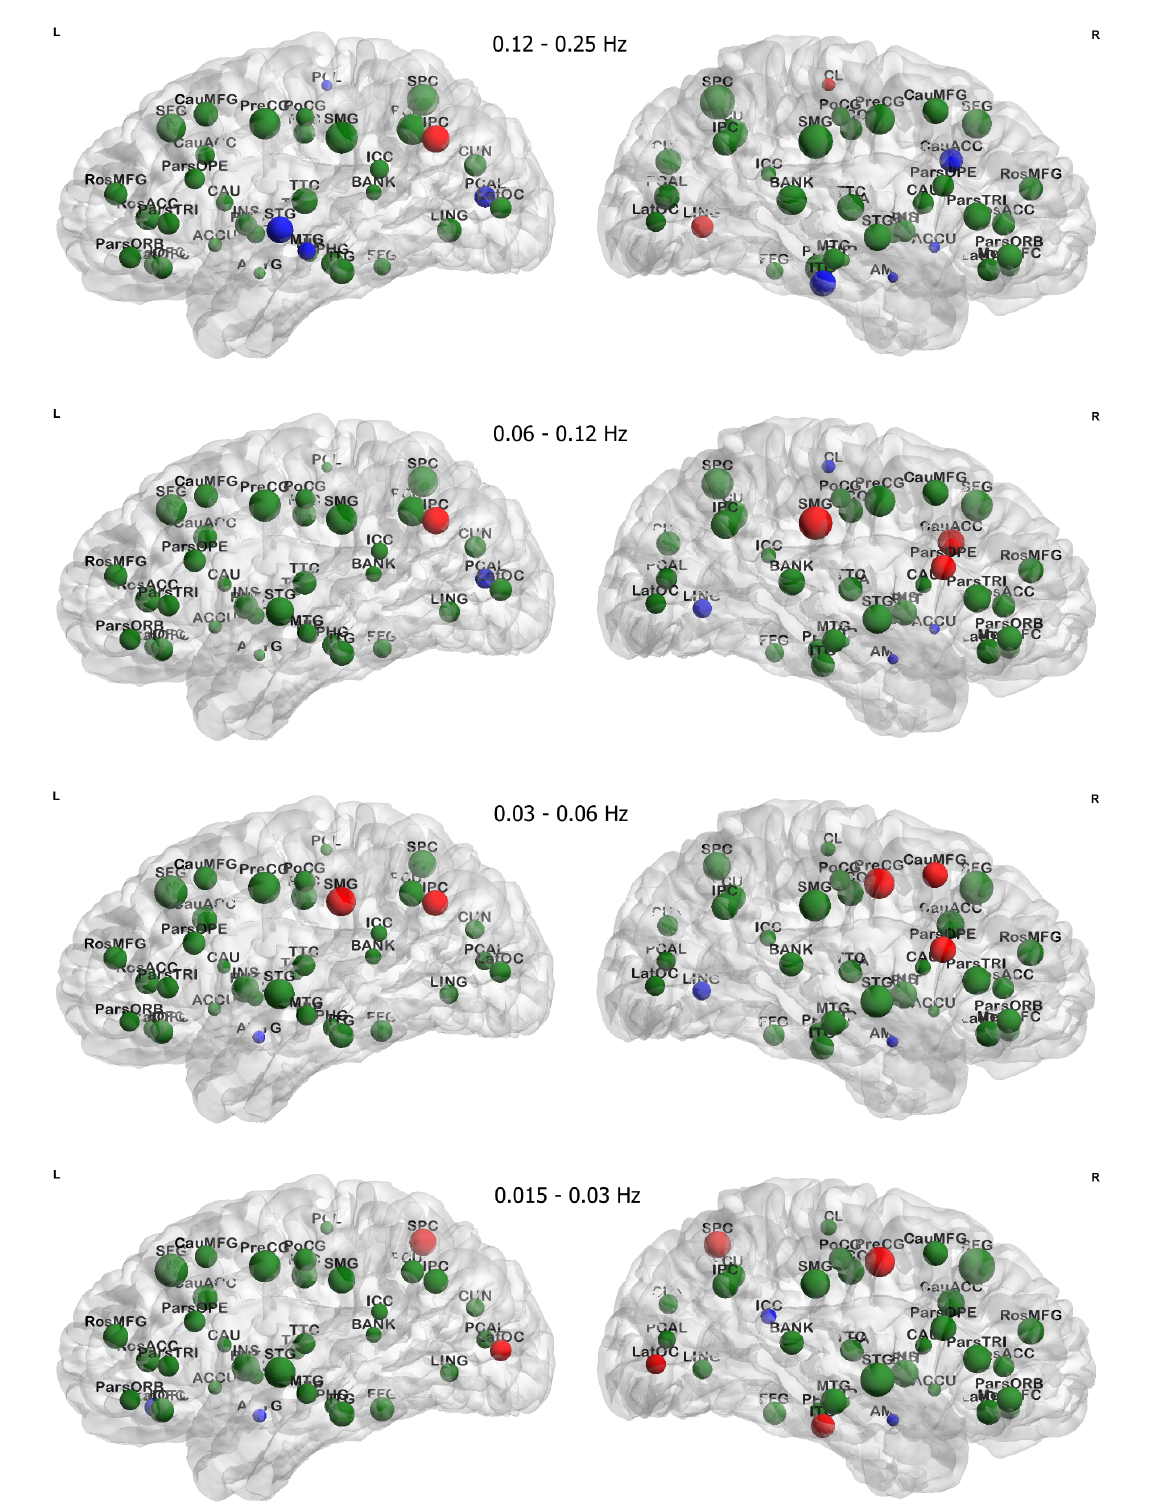
Figure 4. Treatment-induced changes in nodal degree for brain regions are presented. In the figure, before-treatment nodal degree is represented in node size. Significance and direction of change are presented in node color: red nodes for brain regions with (uncorrected p -value < 0.05) increased nodal degree after treatment, blue nodes for regions with decreased degree, and green nodes for regions without changes. Statistics for changes of red and blue regions are summarized in Table 5 and full name of brain regions are listed in Table